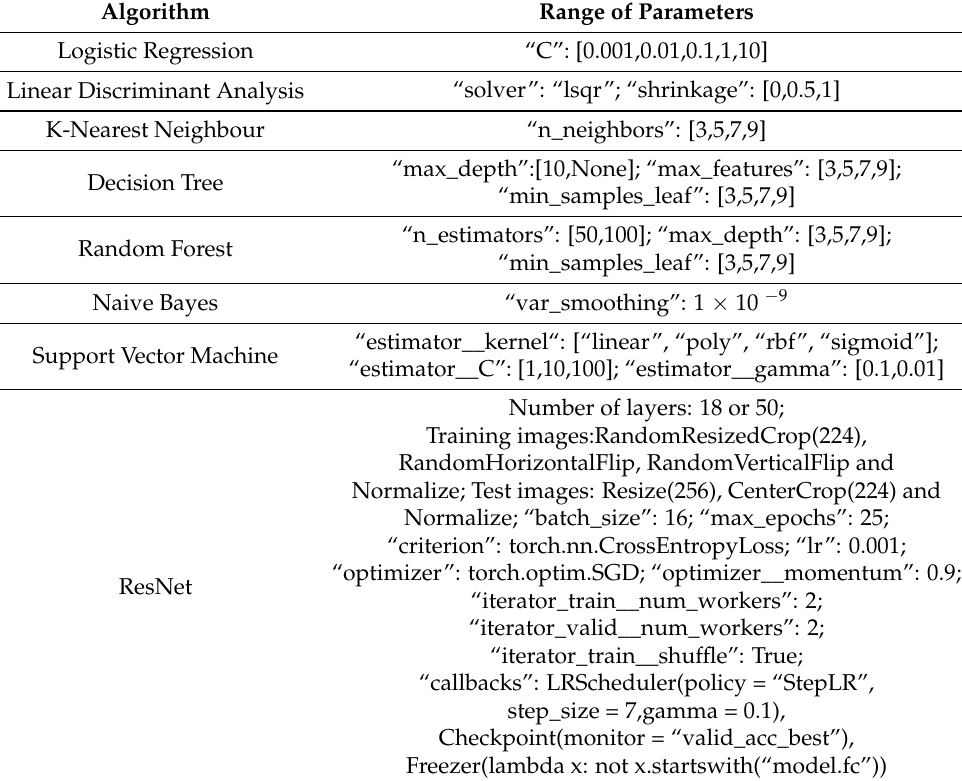
Table 1. Parameters specified for the 5-fold cross-validated grid search for the seven machine-learning algorithms and for the ResNets are listed. Note that a single parameter value was assigned to Naive Bayes, whereas three hyperparameters of the Decision Tree, Random Forest and Support Vector Machine algorithms were